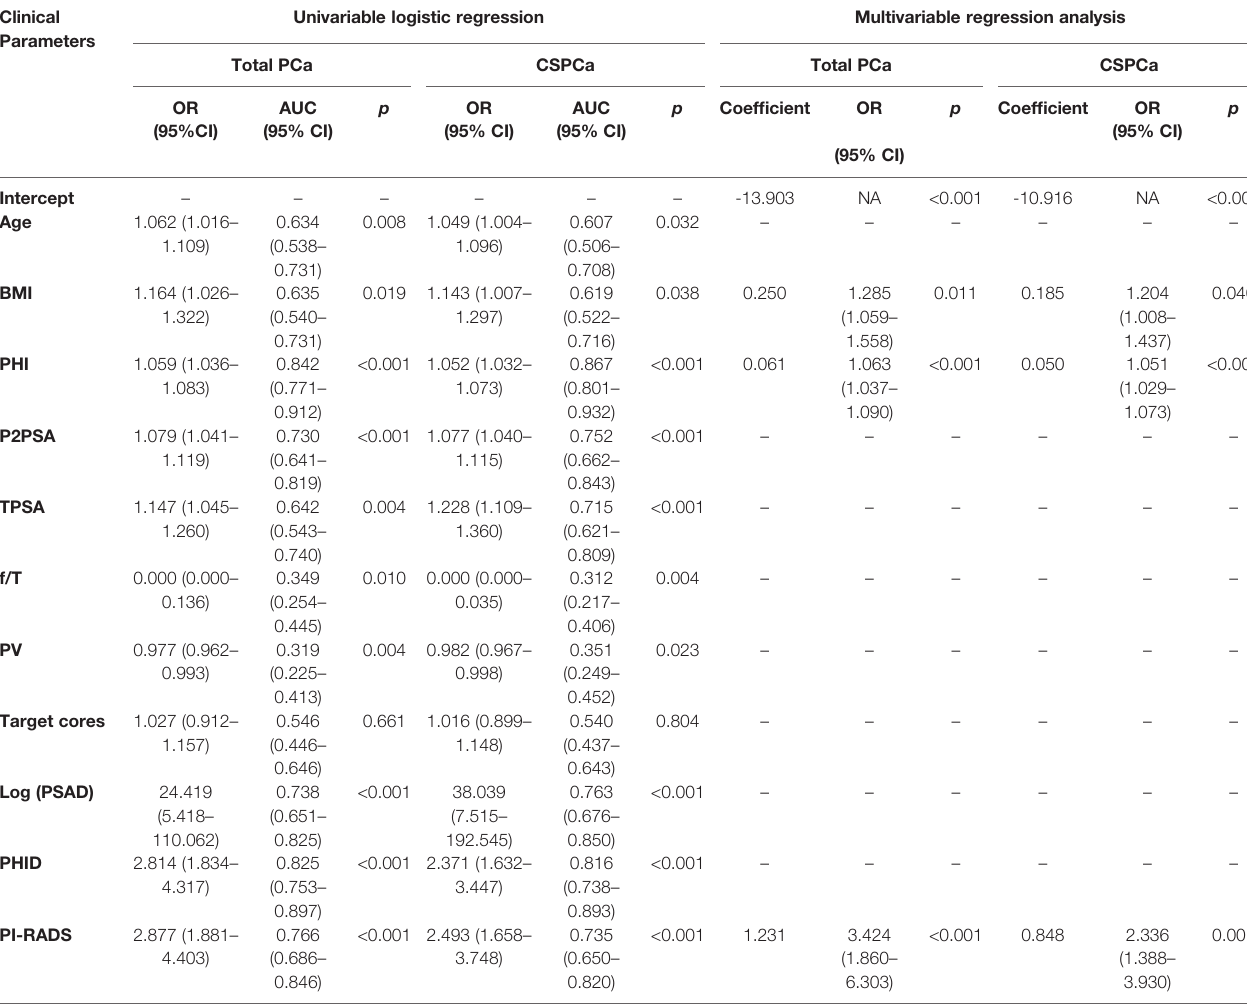
TABLE 2 | Univariable logistic regression analysis for the prediction of total and clinically signi fi cant prostate cancer (CSPCa). Clinical